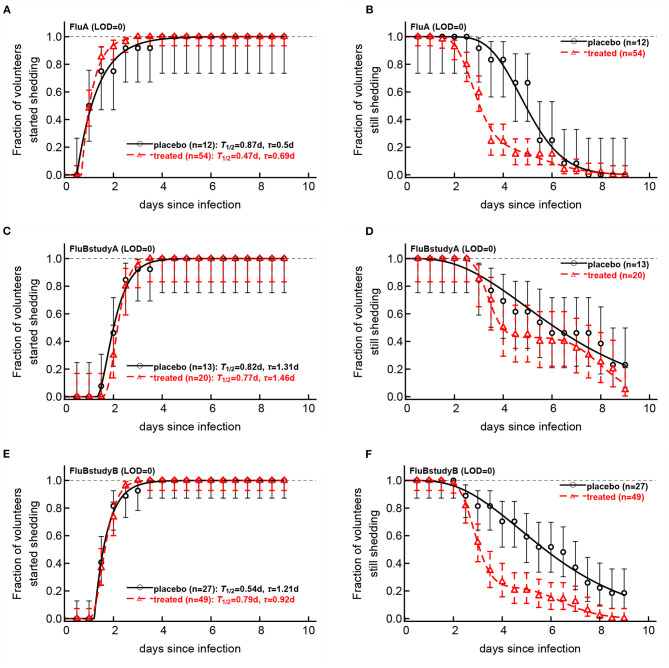
Impact of oseltamivir treatment on kinetics of the start and end of influenza virus shedding. We calculated the cumulative fraction of volunteers that start (A,C,E) or stop (B,D,F) shedding following infection with influenza A (A,B) or influenza B (C–E) viruses. Data are shown by markers for placebo or treated volunteers and in parentheses we show the numbers of volunteers in each cohort. We fitted a general mathematical model (given in Equations 2 or 3) to these data and the predictions of the best fit models are shown by lines. For every fit the minimal number of fitted parameters was selected using a likelihood ratio test. Best fit parameters are shown in Table 3. In panels, T = k/si is the average shedding time and τ is the delay in shedding (see Equation 2 for parameter definition). There was a moderate difference in the kinetics of start of shedding in Flu A study between placebo- and drug-treated volunteers (p = 0.047), but no difference was observed in start of virus shedding two studies with flu B (p>0.2). In FluA study and FluB study B the kinetics of stop of shedding was different between placebo and treated volunteers as judged by the likelihood ratio test (p < 0.001 for both comparisons). Error bars were estimated for binomial proportions using Jefferey's intervals (Brown et al., 2001).